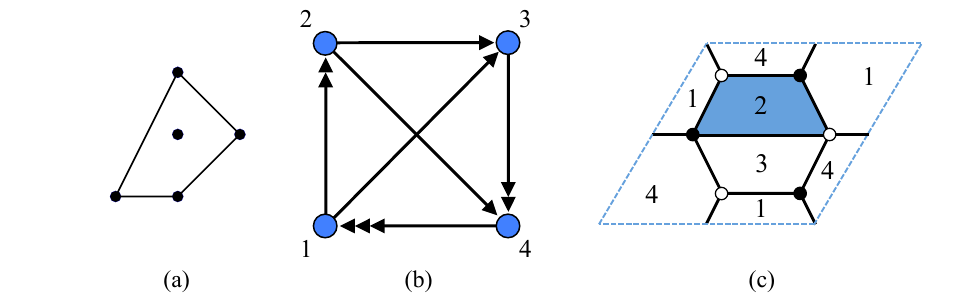
Figure 17. Diagrams for dP 1 : a) toric diagram, b) quiver and c) dimer.